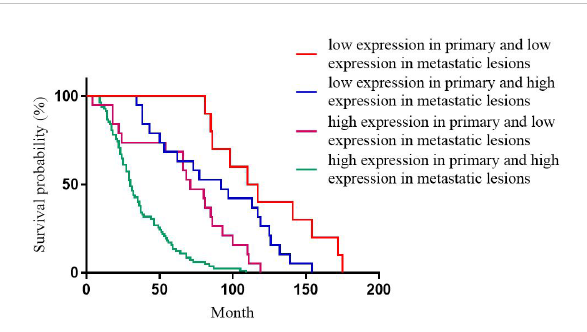
FIGURE 4 Correlation between the heterogeneity of Ki-67 expression and the DFS of patients.